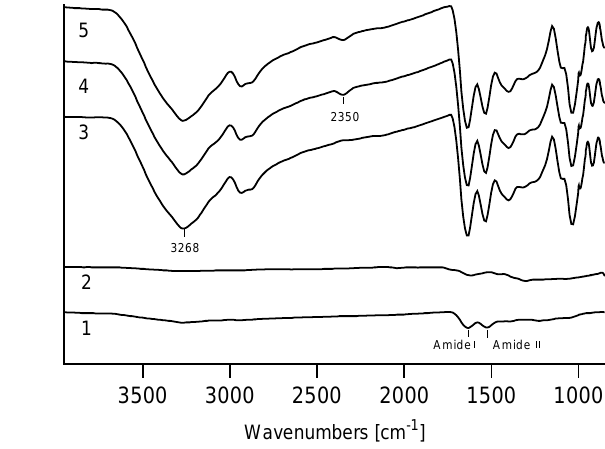
Figure 2. Attenuated total reflection (ATR) spectra of: ( 1 ) keratin, ( 2 ) melanin, ( 3 ) KMF0, ( 4 ) KMF250, ( 5 ) KMF40 .